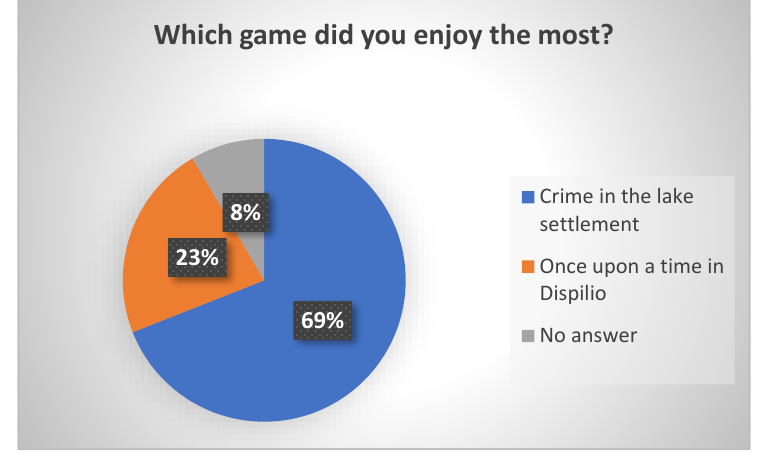
Figure 20. The storytelling game was more engaging.